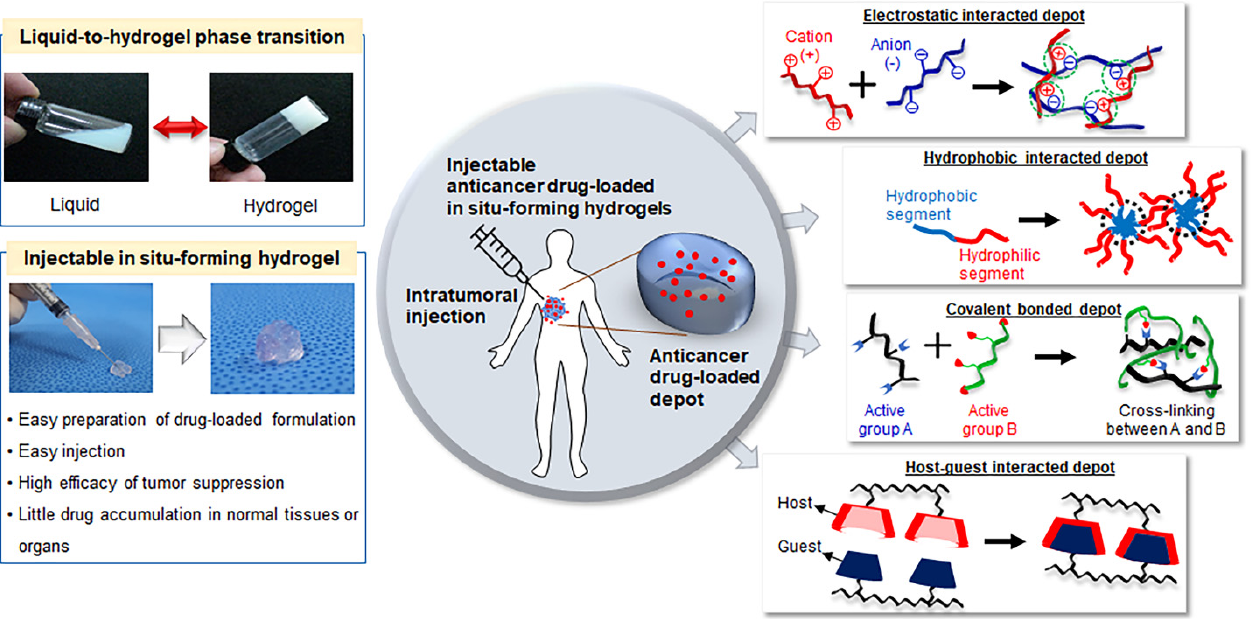
Figure 1. Schematic representation of injectable in situ-forming hydrogel for intratumoral injection (the image was created by G.R.S. and H.E.K. using Adobe Photoshop 7.0).